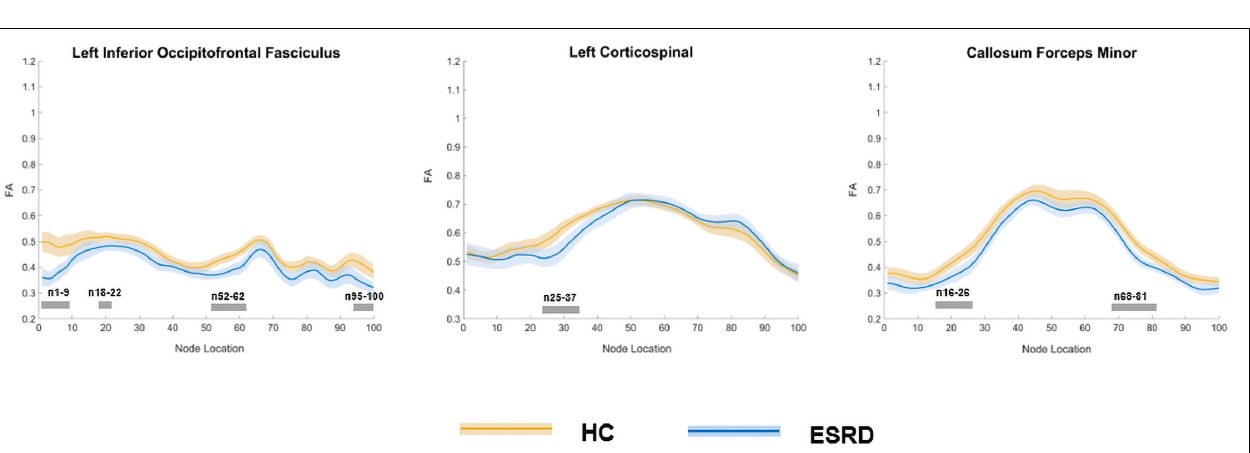
FIGURE 3 | Plots of significantly altered locations in point-wise comparison of FA values between HCs and ESRD ( P < 0.05, FDR correction). The orange line represents the HC group; the blue line represents the ESRD group (solid lines for means and shaded regions for confidence interval). The gray bars at the bottom are the regions of the fiber segment with significant difference between the two groups. ESRD, end stage renal disease; HC, health control; FA, fractional